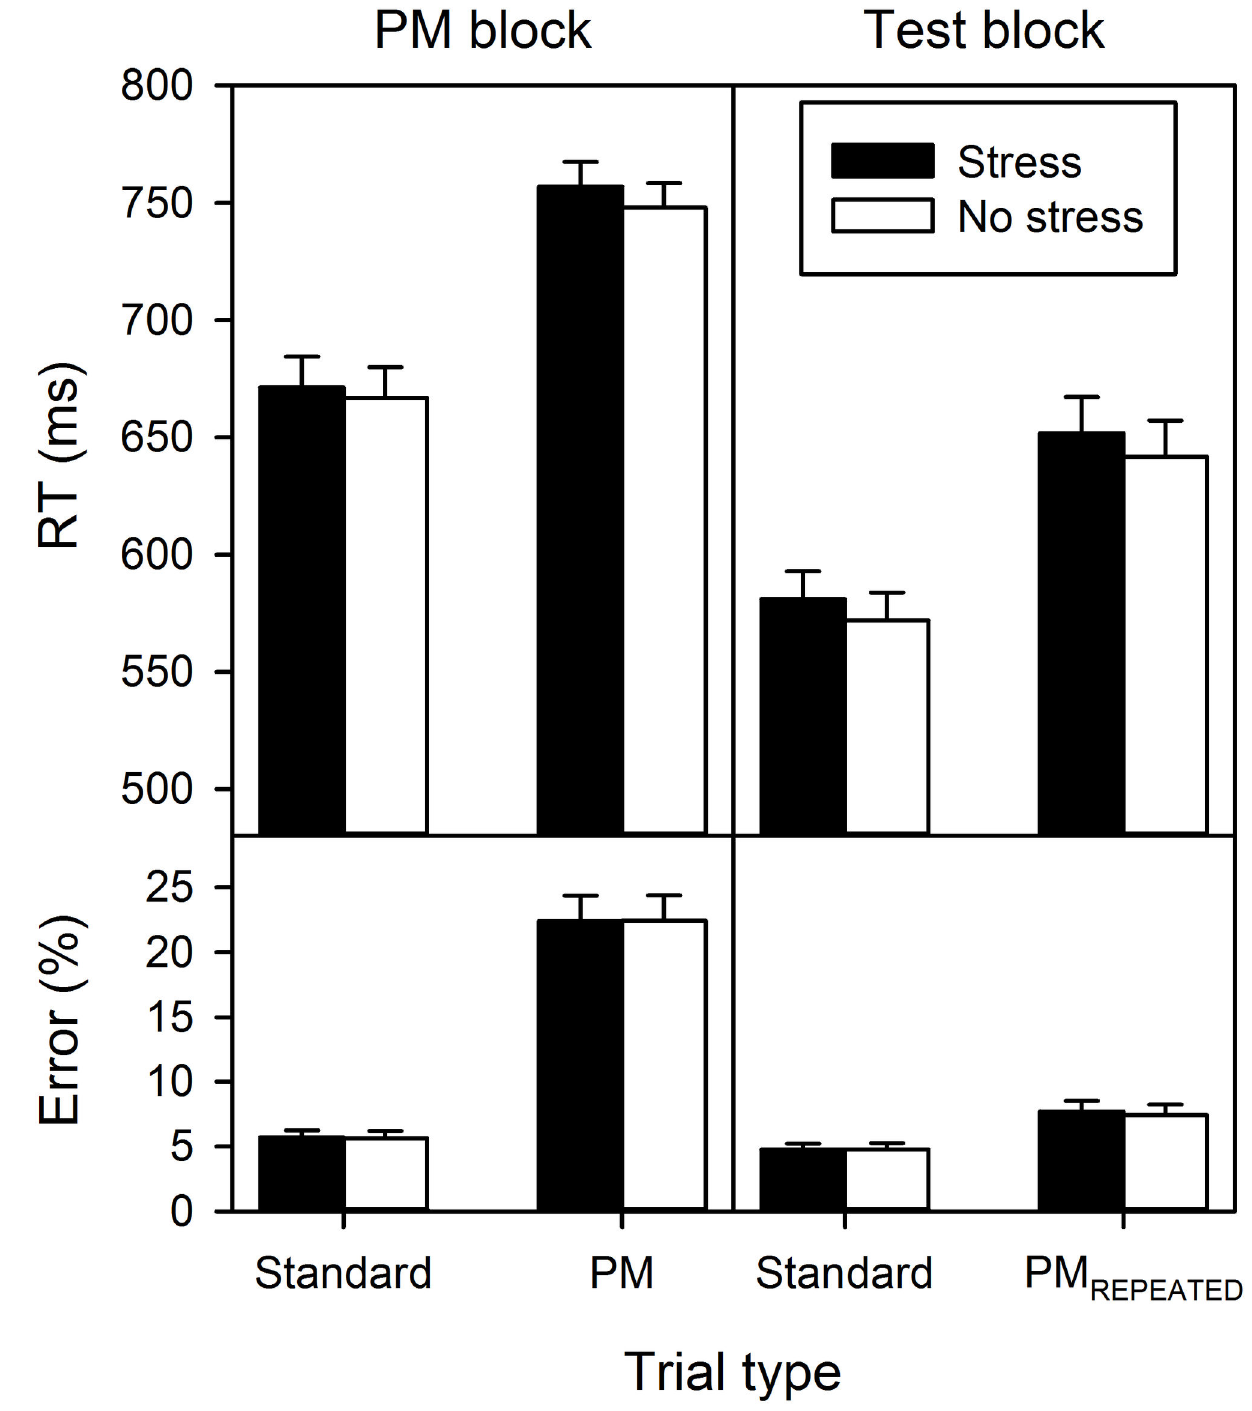
Figure 4. Cognitive performance. Mean response time (RT) and mean error rates for the Prospective memory (PM) block and the Test block as a function of trial type (PM block: standard vs. PM; Test block: standard vs. PM no stress). Error bars represent standard